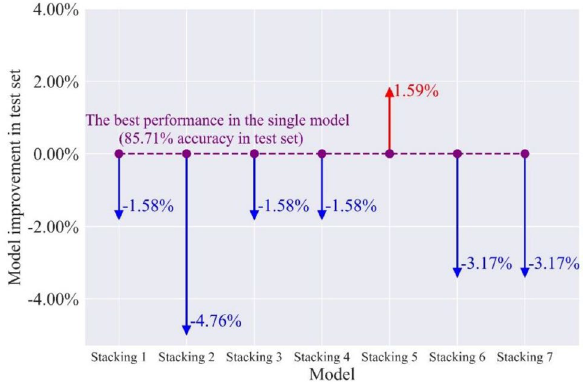
Figure 14. The accuracy improvement of stacking combination models in the test set.